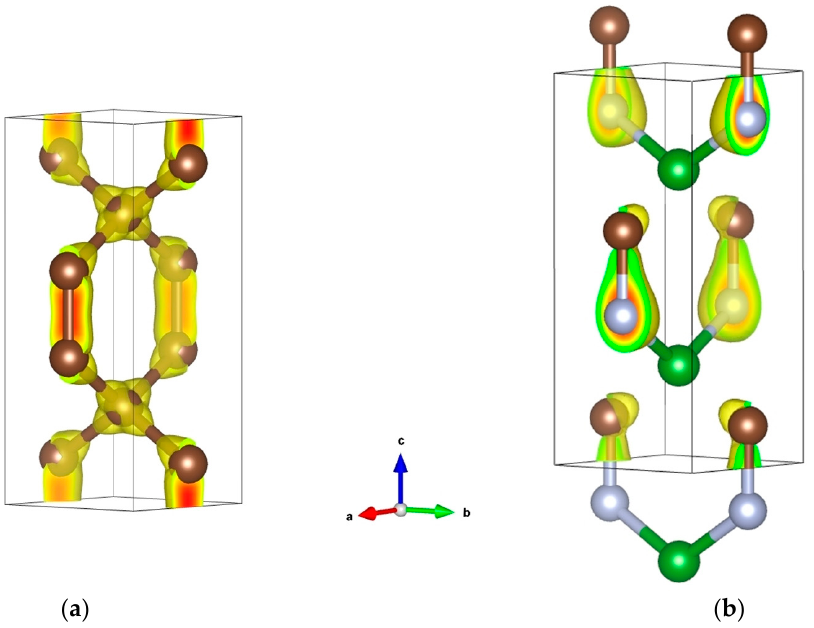
Figure 6. Crystal structures of template ‘glitter’ C 6 ( a ) and tetragonal BCN ( b ) with charge density distributions. Boron, carbon and nitrogen atoms are shown by green, brown and grey spheres, re- spectively.